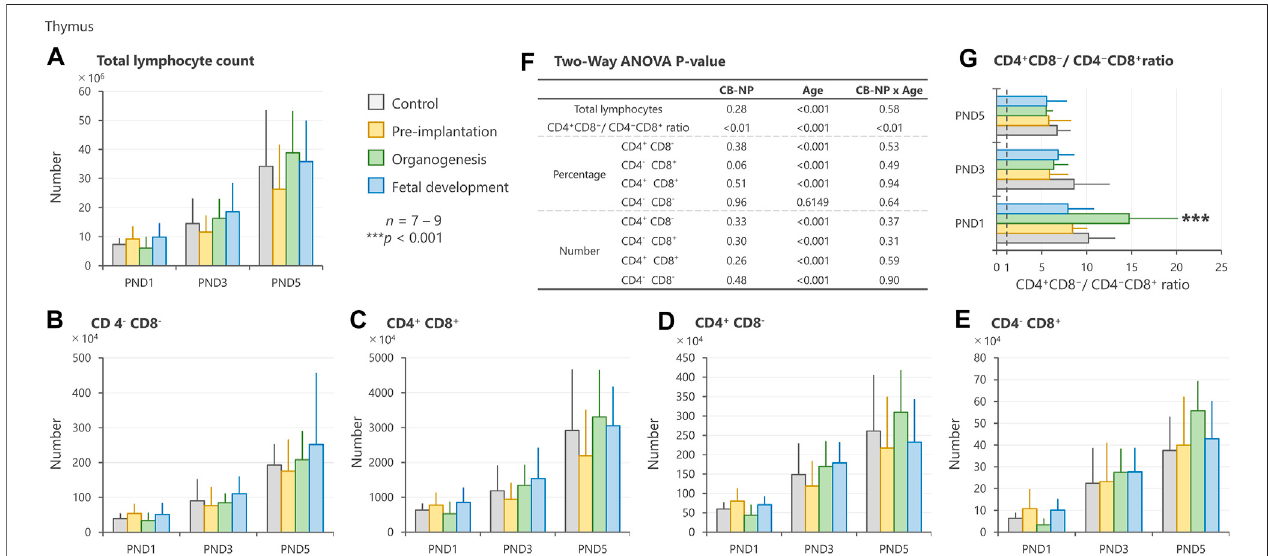
FIGURE 4 | Effect of maternal exposure to carbon black nanoparticle (CB-NP) on the number and percentage of each lymphocyte in the thymus of offspring at postnatal day 1, 3 and 5, as measured by fl ow cytometry. (A) : Number of total lymphocytes in the thymus. (B – E) : Number of each lymphocyte calculated based on the total lymphocytes and percentage of each cell type. (F) : All p-values calculated by two-way ANOVA. Two-way ANOVA showed no signi fi cant effect of CB-NP exposure on the number of (A) total lymphocytes [F (3, 79) (cid:2) 1.32; p (cid:2) 0.28], (B) CD4 − CD8 − [F (3, 79) (cid:2) 0.83; p (cid:2) 0.48], (C) CD4 + CD8 + [F (3, 79) (cid:2) 1.38; p (cid:2) 0.26], (D) CD4 + CD8 − [F (3, 79) (cid:2) 0.82; p (cid:2) 0.33], and (E) CD4 − CD8 + [F (3, 79) (cid:2) 1.22; p (cid:2) 0.30]. (F) A signi fi cant effect of CB-NP exposure was detected on the CD4 + CD8 − / CD4 − CD8 + ratio [F (3, 79) (cid:2) 4.12; ** p (cid:2) 0.0090] with signi fi cant exposure/age interaction [F (6, 79) (cid:2) 3.78; ** p (cid:2) 0.0023]. The Tukey post-hoc test showed that (G) the CD4 + CD8 − /CD4 − CD8 + ratio after CB-NP exposure during the organogenesis period was higher than that of the control (** p (cid:2) 0.0081), pre-implantation period (*** p < 0.001), and fetal developmental period groups (*** p < 0.001) on postnatal day 1. Values are expressed as mean ±